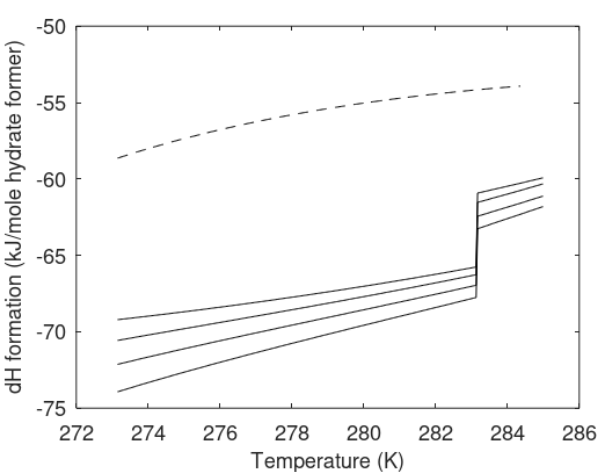
Figure 6. Enthalpies of hydrate formation in kJ/mol hydrate former as function of temperature. For temperatures below the CO 2 phase transition point (roughly 283.4 K), the bottom solid curve corresponds to CO 2 /CH 4 mixture with 10 mol % CH 4 ; the top solid curve is pure CO 2 ; 5 mol % CH 4 and 2 mol % CH 4 curves fall in between. For temperatures above the CO 2 phase transition point, the order of curves is reversed. The dashed curve is the corresponding results for pure CH 4 hydrate.